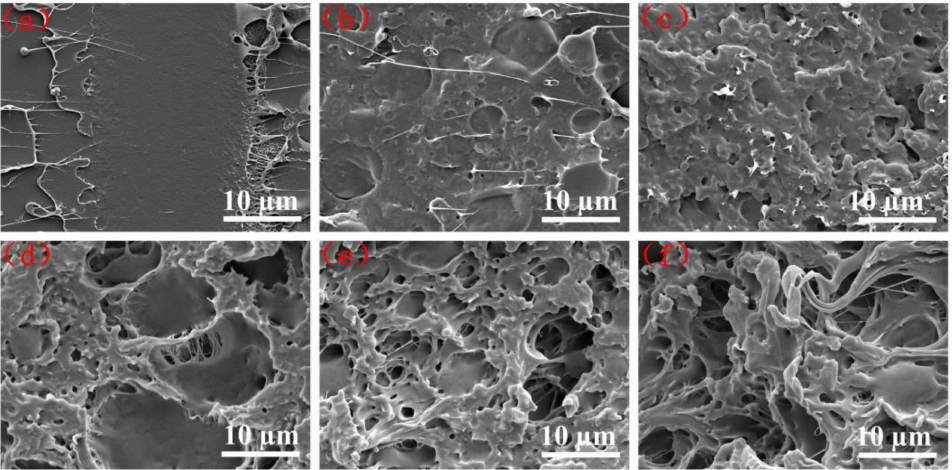
Figure 6. SEM micrographs of impact fracture surfaces: ( a ) neat PLA; ( b ) 70/30; ( c ) 70/30/5; ( d ) 70/30/10; ( e ) 70/30/15; ( f )